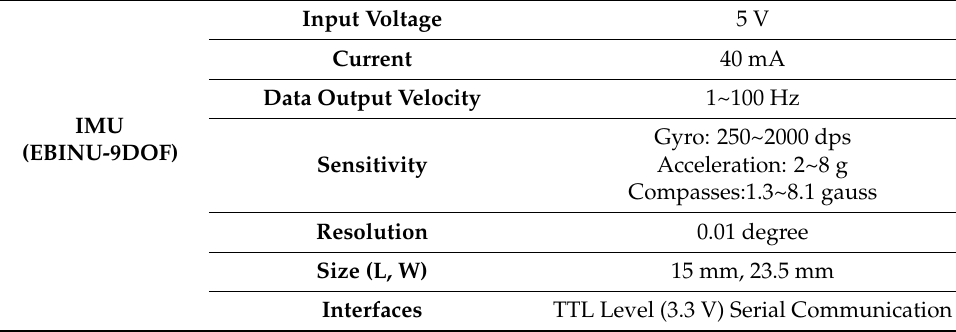
Table 2. The specifications of IMU (Inertial Measurement Unit).